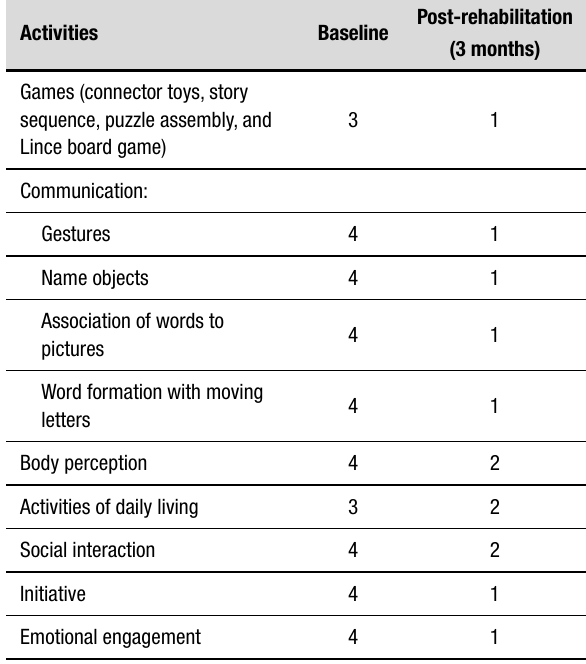
Table 2. Description of rehabilitation program activities. Activities